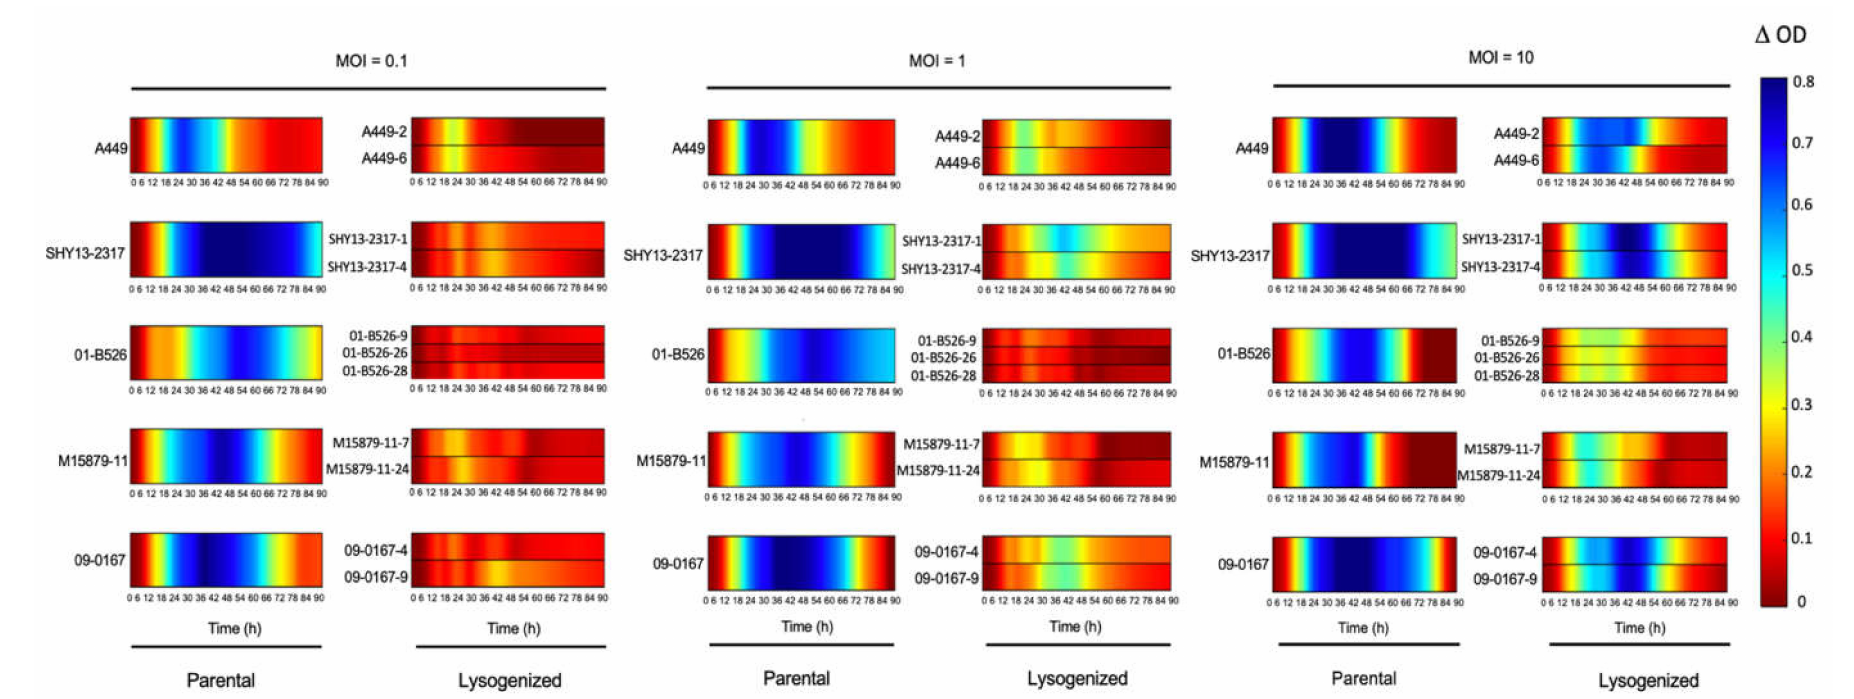
Figure 5. Confirmation of the role of Prophage 3 on the effectiveness of the phage Cocktail T. The comparison of the efficacy of the phage cocktail T on parental strains without Prophage 3 and the lysogenized strains containing Prophage 3 are shown at three different MOIs. For each MOI, the parental strains are illustrated in the first column, and the second column contains the strains lysogenized with Prophage 3. The colored lines representing the growth inhibition by phages have been deduced as shown in Figure 1. When the bacterial growth is highly inhibited, the color of the line will tend to blue. No inhibition corresponds to red